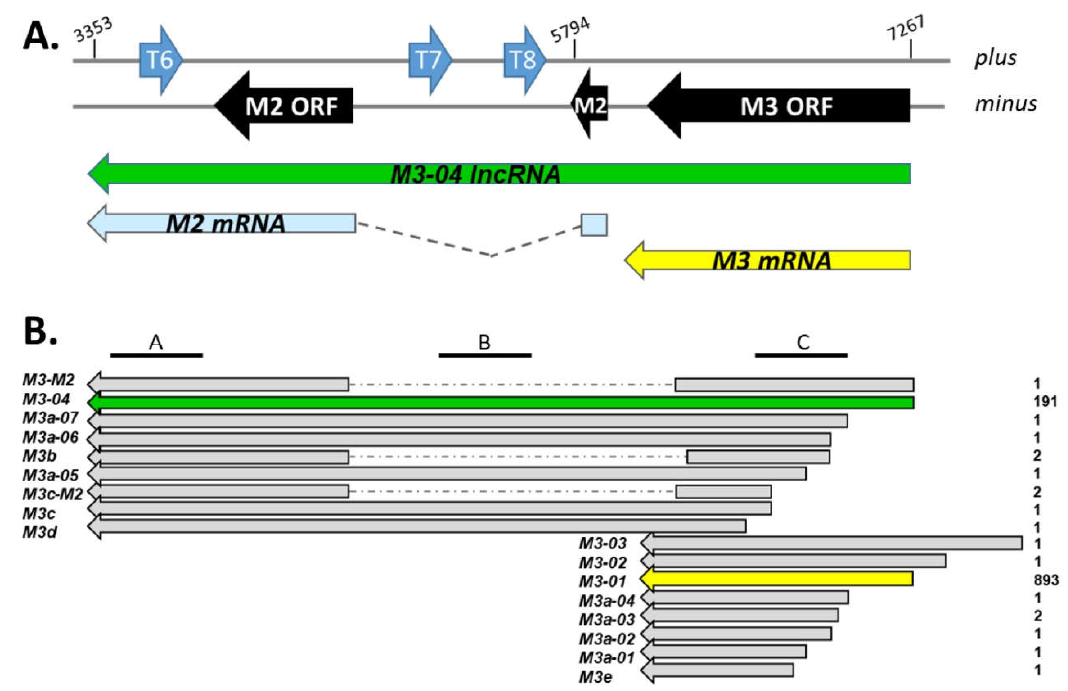
Figure 1. Map of genes and transcripts within the M3/M2 locus. ( A ) The M3/M2 locus across plus and minus strands of the MHV68 genome. ORFs are indicated in black, TMER genes are indicated in blue. Below the genome, the major RNA transcripts within the locus are indicated, including M3-04 (nt positions 7267 to 3353 within NC_001826.2). ( B ) M3/M2 locus transcripts identified through TRIMD analysis of multi-platform transcriptomics data sets. Transcript names are indicated at left, TRIMD scores for each transcript are indicated on the right. Location of northern blot probes A, B, and C are indicated at top.